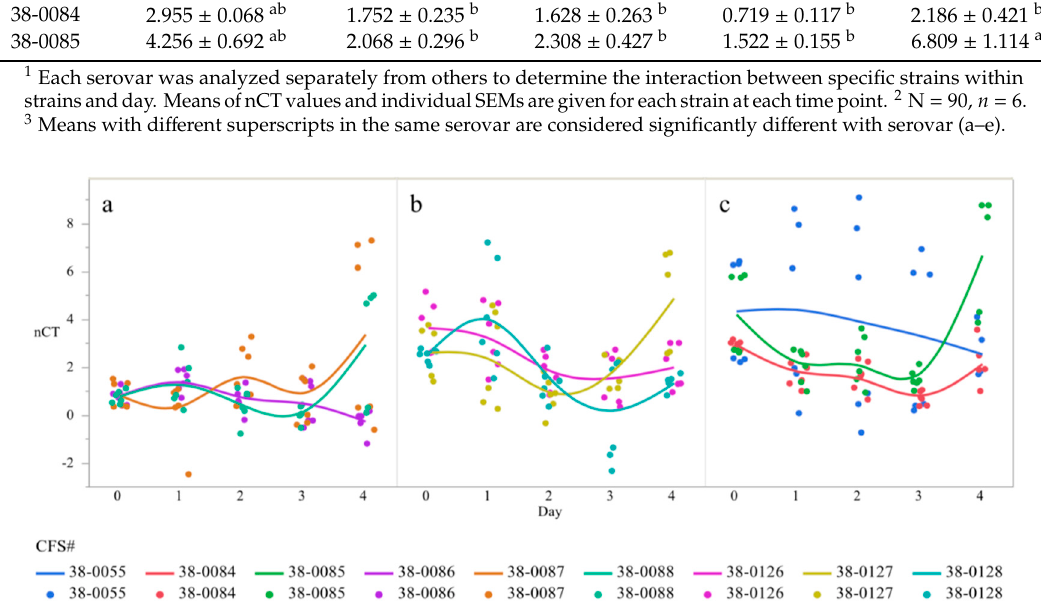
Figure 3. Differences in expression of the gene csgD over time in strains of Salmonella Heidelberg ( a ), Enteritidis ( b ),and Kentucky ( c ) 1 . qRT-PCR was performed on total RNA isolated from bacterial cultures of Salmonella as pellicles were being formed over a 4-day time period 1 N = 90, n = 6, p = 0.0006 ( a ), 0.003 ( b ), 0.0211 ( c ).